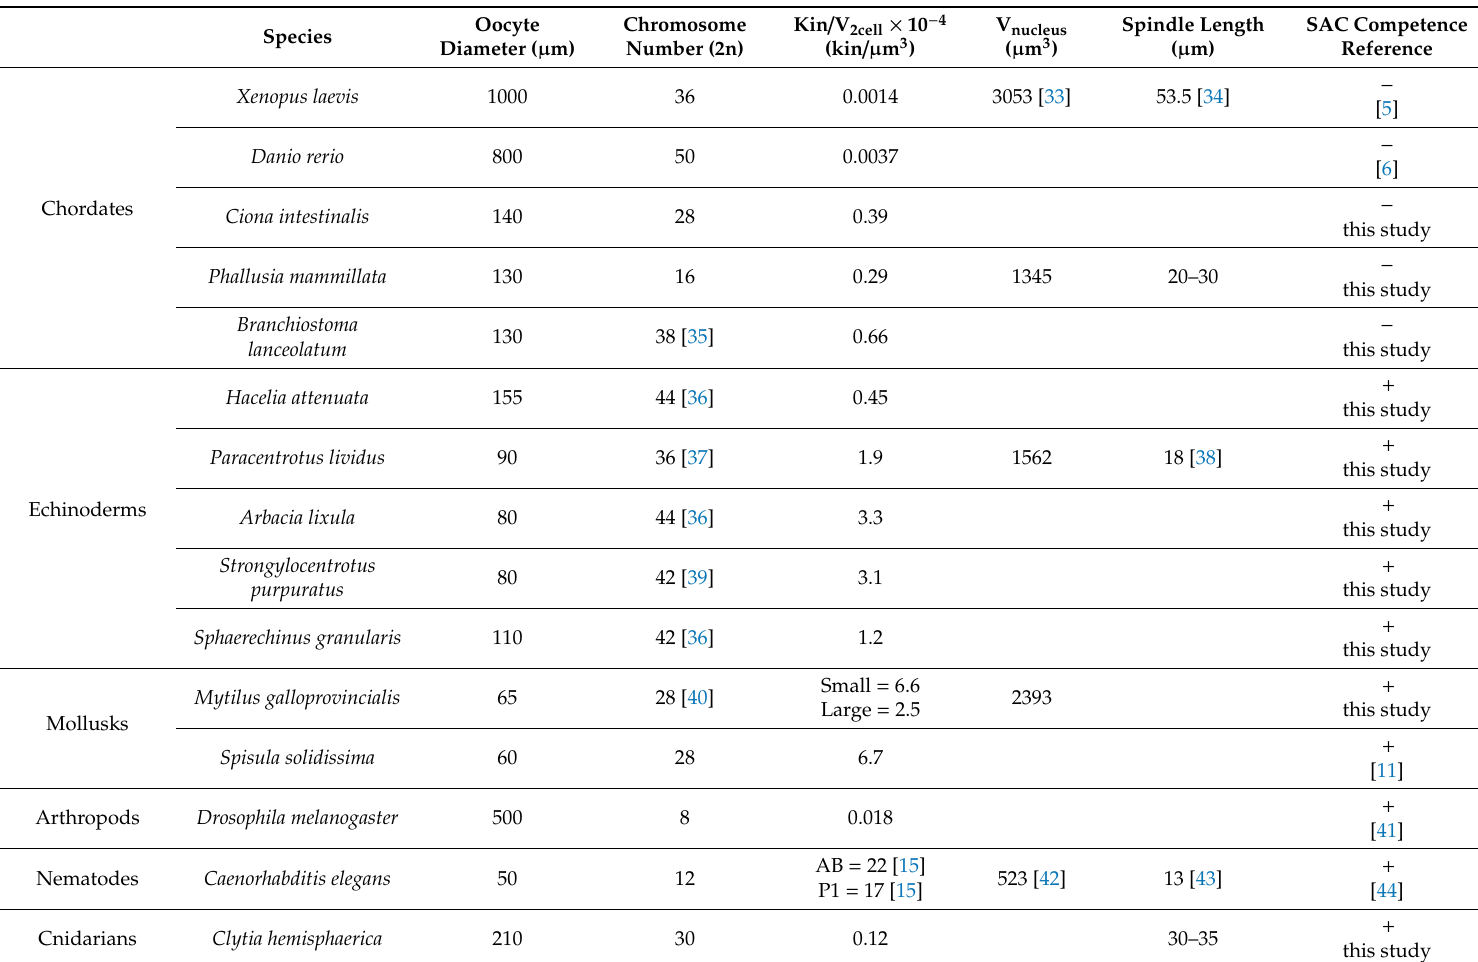
Table 1. Morphometric data for embryos of all analyzed